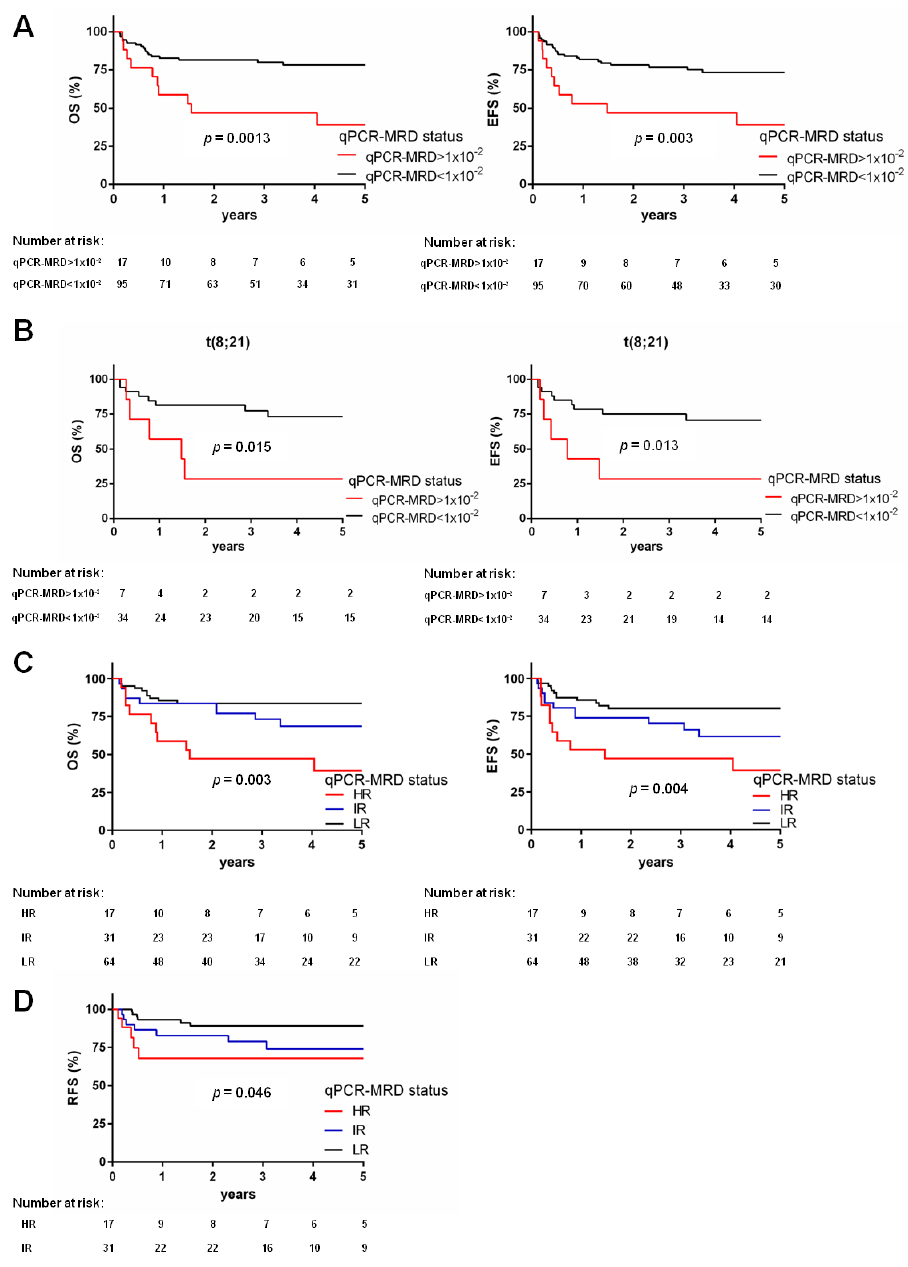
Figure 3. Two qPCR-MRD thresholds generate a risk stratification model predicting the survival of patients: ( A ) Survival estimates for patients receiving HSCT with qPCR-MRD values above 1 × 10 − 2 ( n = 17) and qPCR-MRD values below 1 × 10 − 2 ( n = 95). Curves show OS (left, 39.2% vs. 78.2%, p = 0.0013) and EFS (right, 39.2% vs. 73.4%, p = 0.003); ( B ) five-year survival curves for patients harboring t(8;21) RUNX1::RUNX1T1 rearrangement given HSCT with qPCR-MRD values above 1 × 10 − 2 ( n = 7) and qPCR-MRD values below 1 × 10 − 2 ( n = 34): OS (28.6% vs. 73.2%, p = 0.015) and EFS (28.6% vs. 70.7%, p = 0.013); ( C ) Kaplan–Meier curves of OS or patients who underwent HSCT with qPCR-MRD values above 1 × 10 − 2 (HR, n = 17), 2.1 × 10 − 4 < qPCR-MRD values < 1 × 10 − 2 (IR, n = 31), and qPCR-MRD values below 2.1 × 10 − 4 (LR, n = 64) (survival 39.2% vs. 68.6% vs. 83.7%, respectively, p = 0.003) and EFS (survival 39.2% vs. 61.6% vs. 80.2%, p = 0.004); ( D ) relapse-free survival of patients according to three risk stratification model: qPCR-MRD values above 1 × 10 − 2 (HR, n = 17), 2.1 × 10 –4 < qPCR-MRD values < 1 × 10 − 2 (IR, n = 31), and qPCR-MRD values below 2.1 × 10 − 4 (LR, n = 64) (67.9% vs. 73.9% vs. 89.2%, respectively, p =